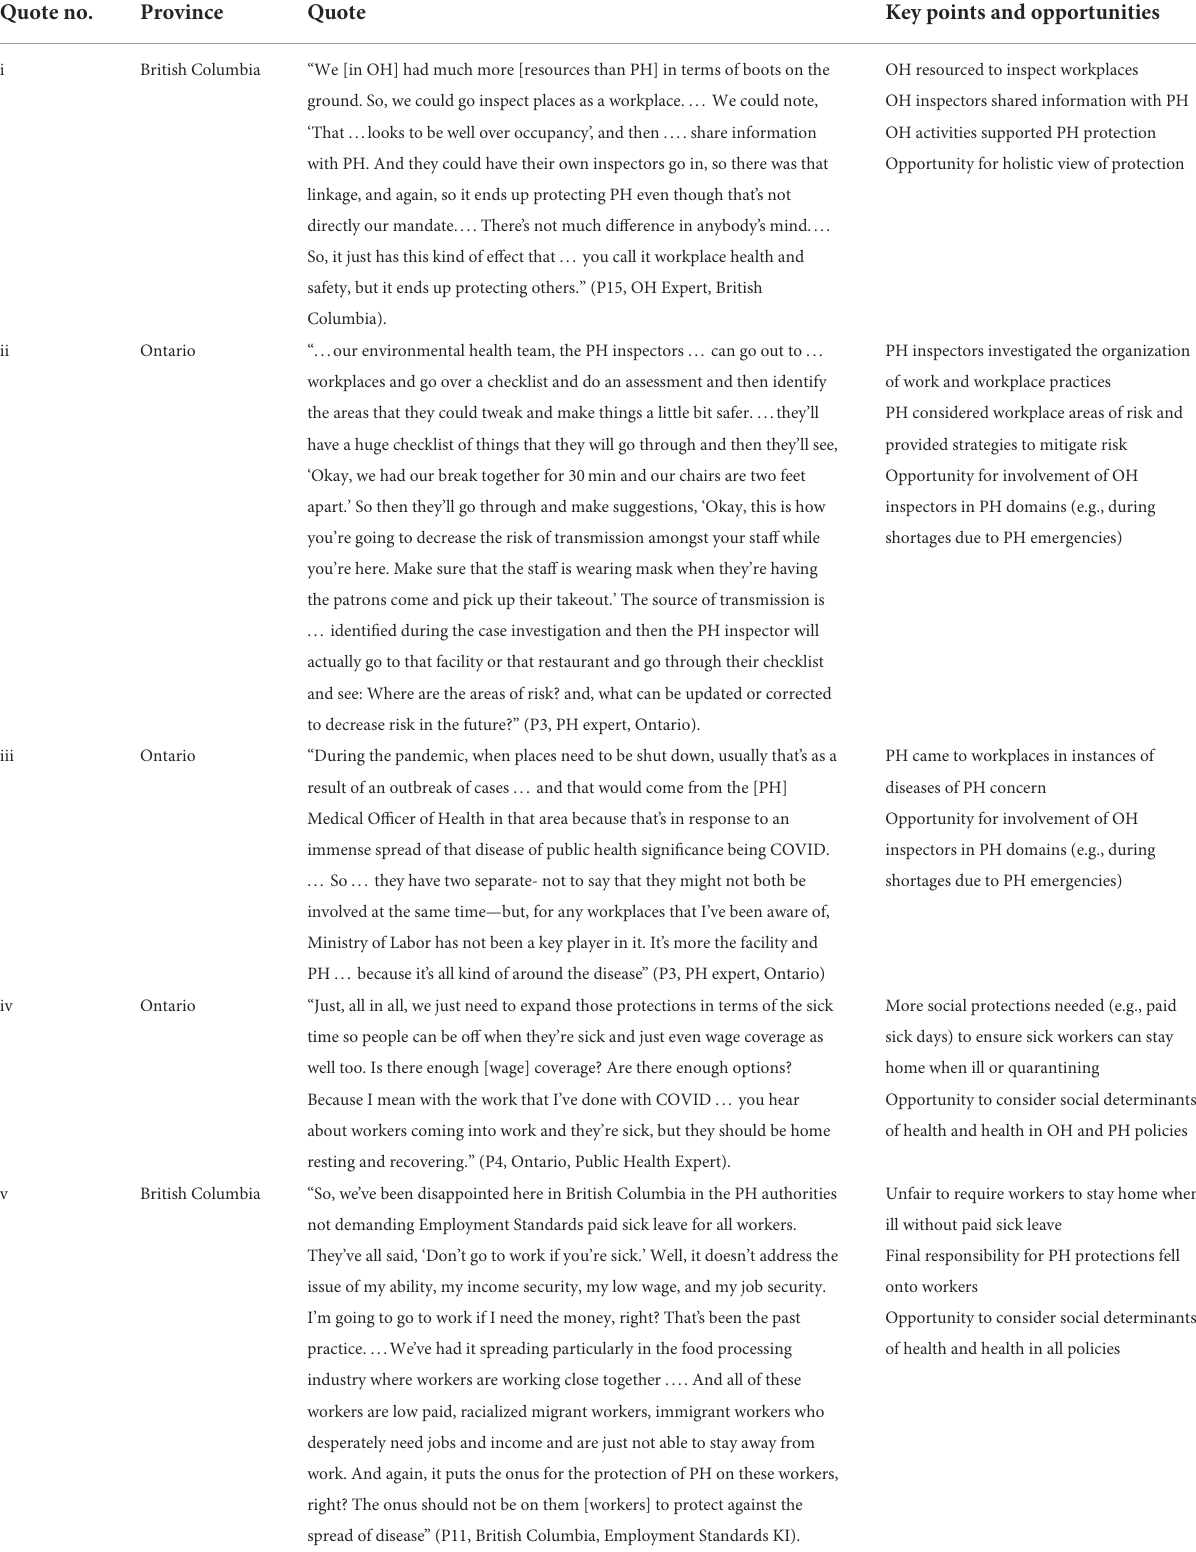
TABLE 5 Opportunities: Key points identified from quotes about PH-OH pandemic response and KI province. Quote no. Key points and